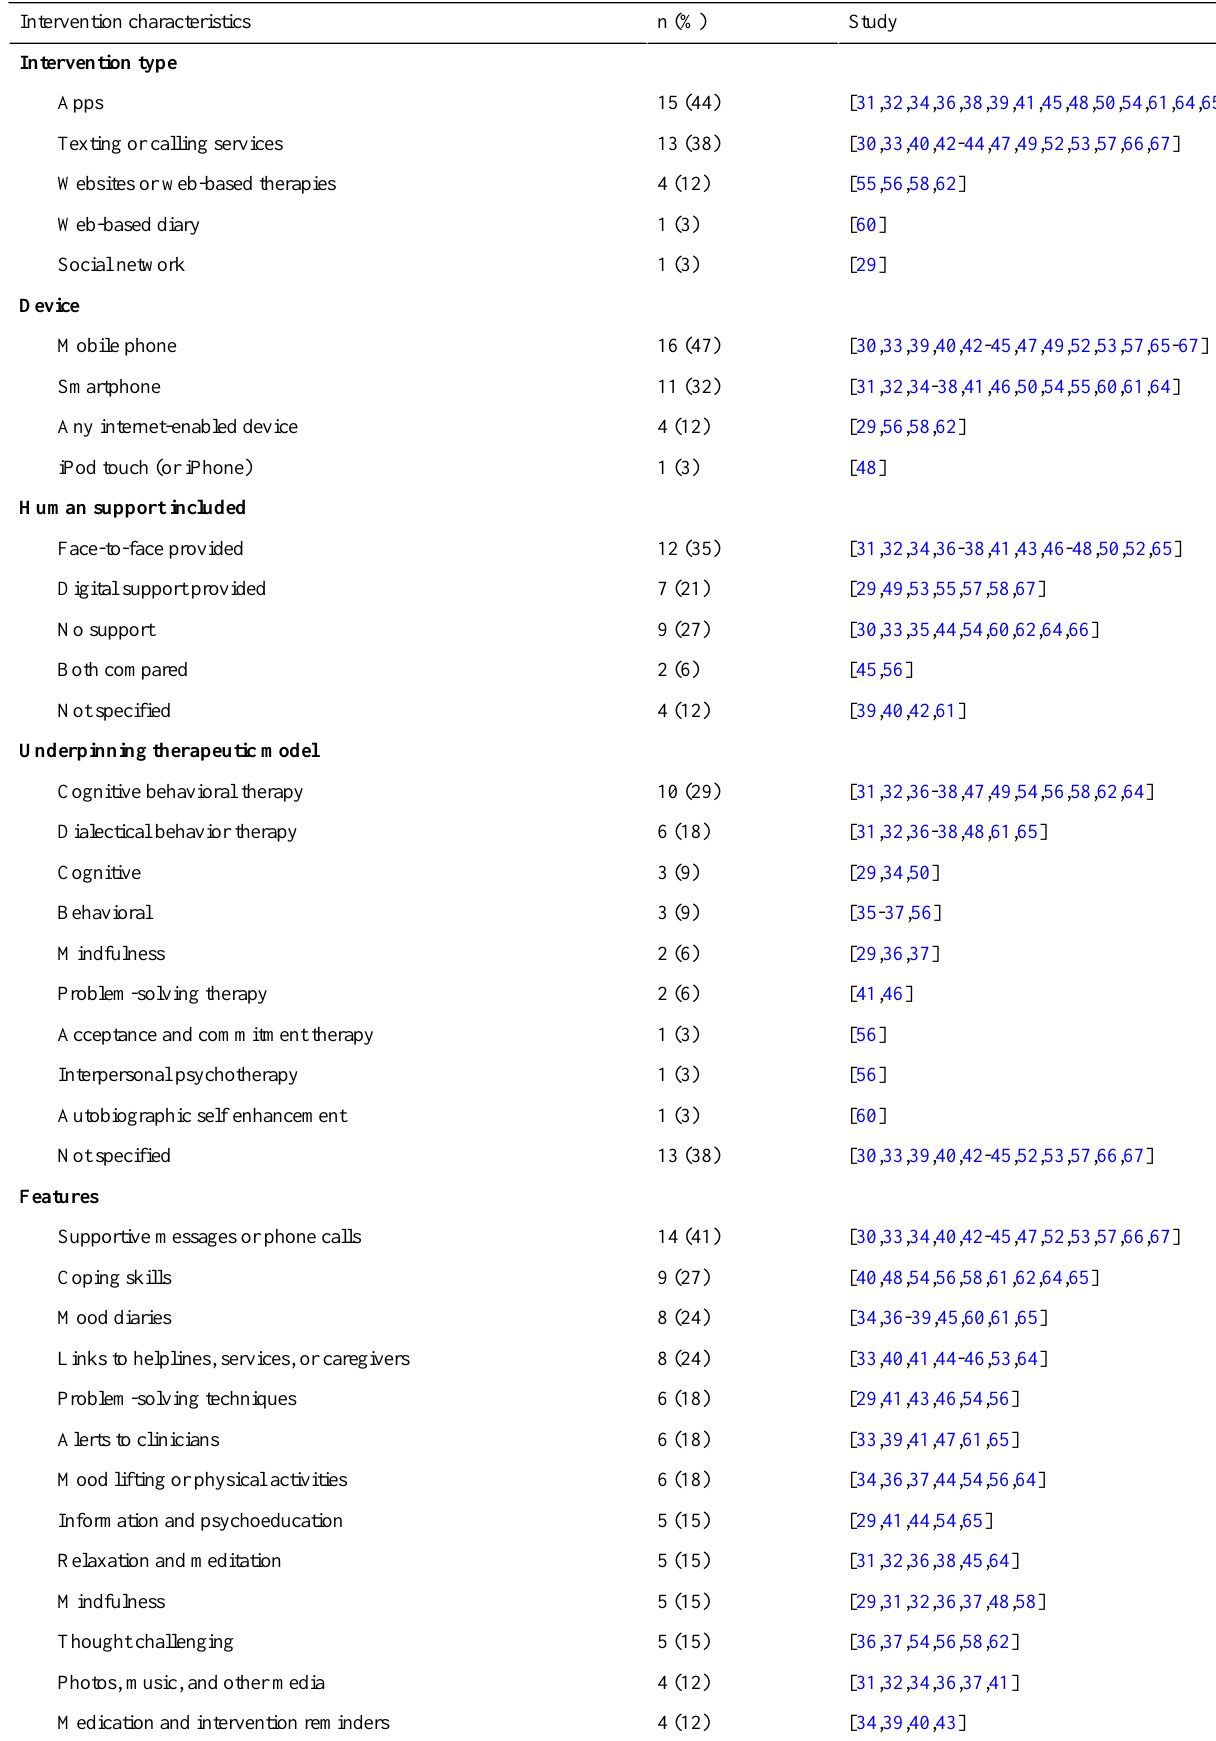
Table 3. Intervention characteristics (n=34). a